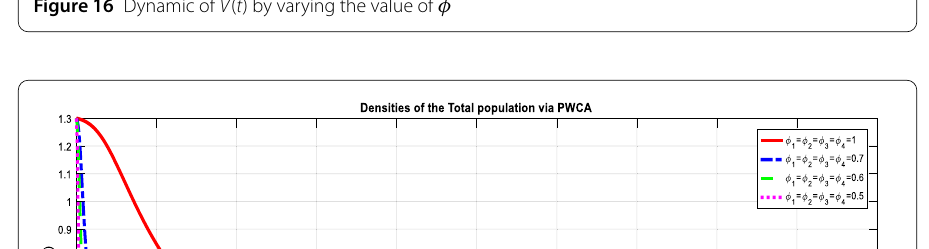
Figure 17 Dynamic of N ( t ) by varying the value of φ